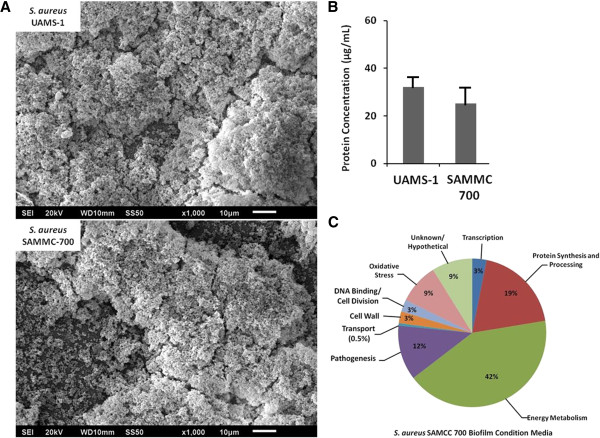
Soluble factors produced by Staphylococcus aureus biofilms. A) Representative SEM images of S. aureus strain UAMS1 (top panel) and SAMMC −700 (bottom panel) after 48 hr growth (scale bars =10 μm). B) Total protein (μg/mL) within the BCMs of S. aureus clinical strains as determined by the BCA assay. C) Proteomic analysis of BCM from S. aureus strain SAMMC-700 by mass spectroscopy. Proteins identified within the BCM were separated into functional categories, and represented as a percentage of the total proteins identified.